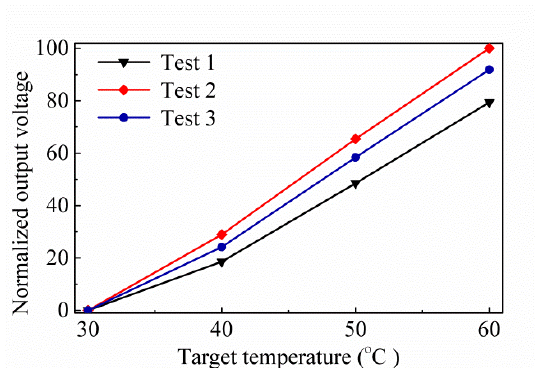
( b ) Figure 10. Setups of the experimental measurement framework of the output voltage ( a ) and the frequency response ( b ) for the trial thermopiles. Further, the proposed thermopile is investigated for its speed of response, and the frequency response measurement setup is established for analysis in Figure 10b. Here, a controller modulates the mechanical chopper. There is a reference frequency from the controller that is delivered to a lock-in amplifier to acquire the frequency response of thermopile output voltage V th . The floating structure of thermopile is the same as the previous study, where the measurement time constant is similar about 4.8 ms, and the corresponding bandwidth is 32 Hz. Figure 11 shows the normalized output voltages normalized by normalized by the maximum of test 2 case for three proposed thermopiles. When comparing Figure 11 with Figure 9, it can be found that the normalized experiment results are similar to the normalized simulation results. Table 4 shows the simulation results of the normalized IAE normalized by the maximum of them at target temperature 60 °C for